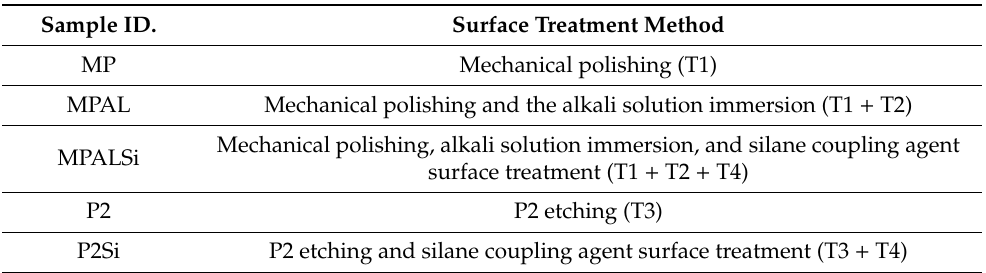
Table 1. The di ff erent surface treatments applied to the Al alloy sheets. Sample ID.